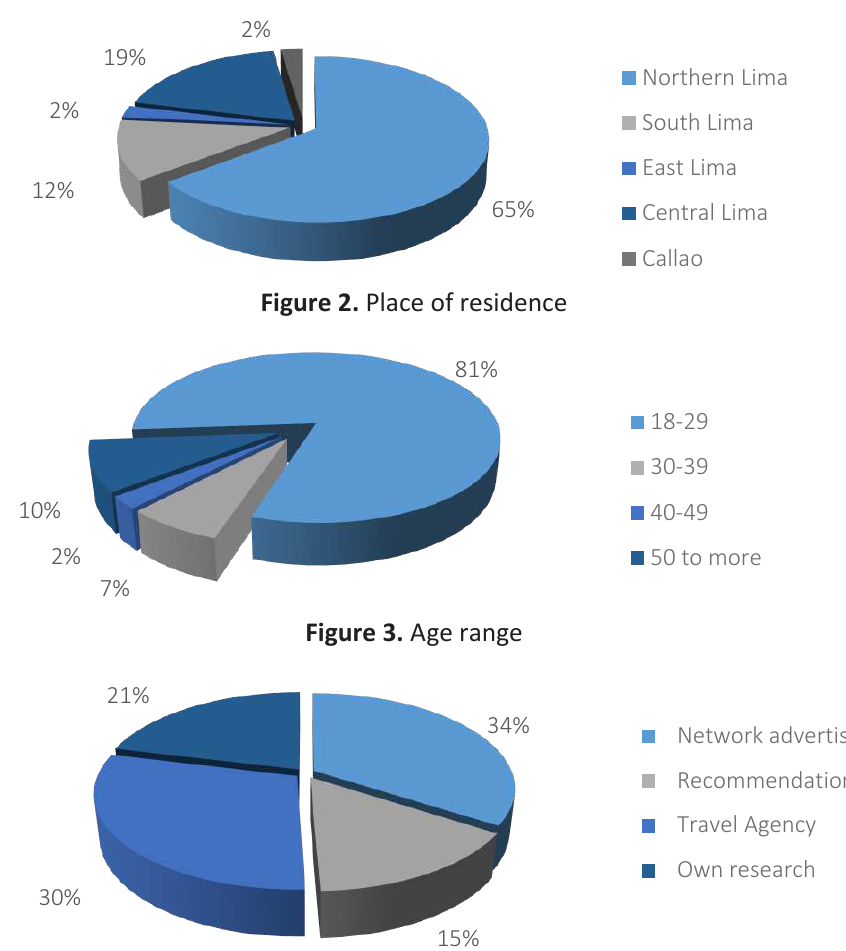
Figure 3. Age range